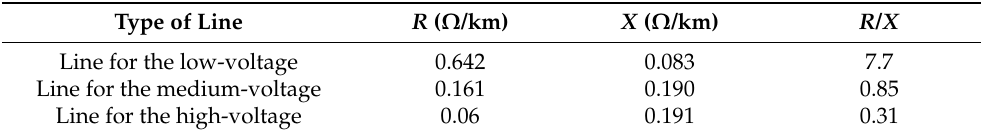
Table 1. Typical line parameters of different voltage